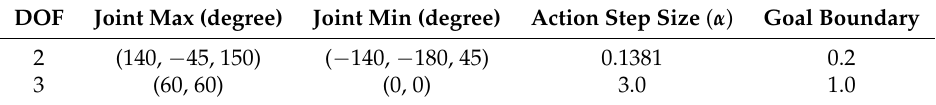
Table 1. Parameters of 2-DOF and 3-DOF manipulators.